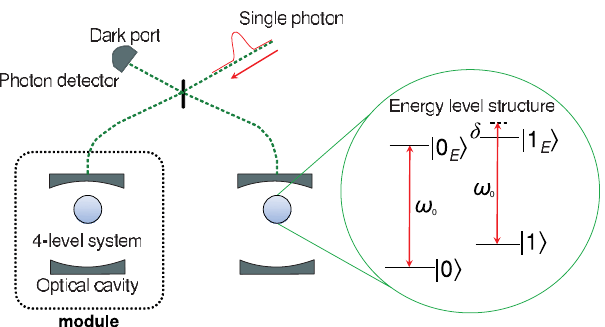
FIG. 1. Schematic representation illustrating the module and the entanglement distribution scheme. The module contains an optical cavity with a four-level system. The entanglement distribution scheme is based on a Michelson interferometer where two modules are connected via an optical fiber [7,8,44,46]. A single photon comes in from the right port and is conditionally reflected at each module depending on the state of the emitter. Erasing the path information at the beam splitter followed by detection at the dark port projects the system to the singlet Bell